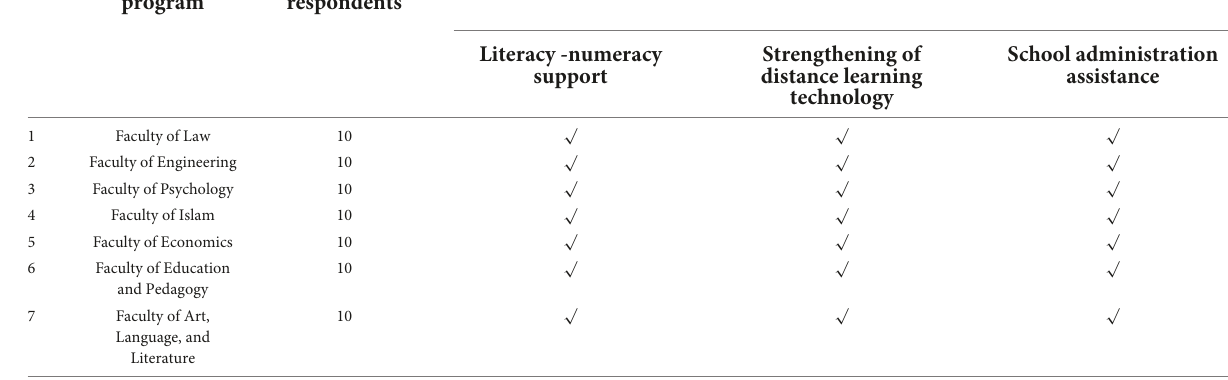
TABLE 2 Interview results data from teaching campus students: COVID-19 ambassador humanitarian project activities. No Teaching Campus Program Literacy and numeracy support, including Koranic